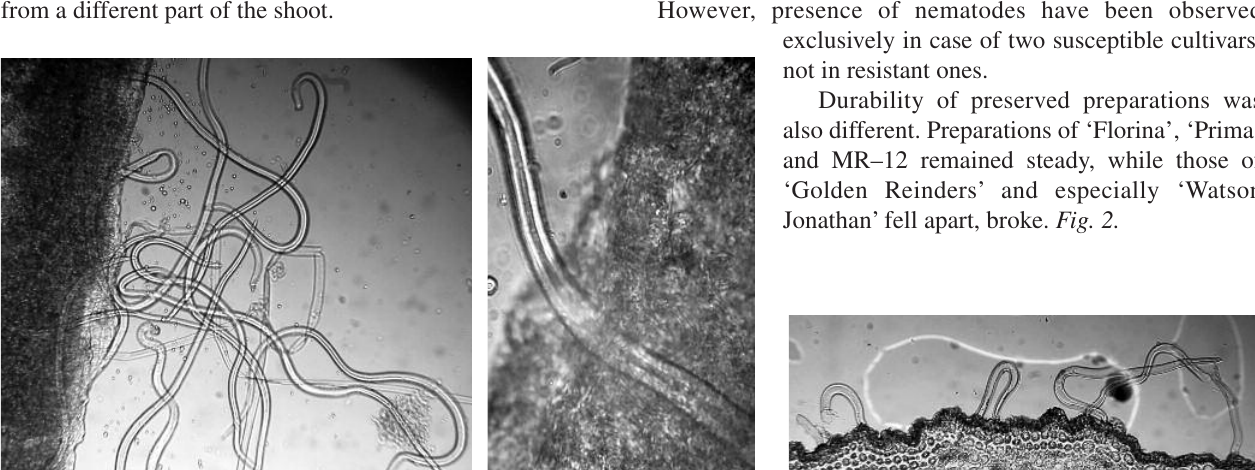
Figure 1. Nematodes appearing around cross sections. Above: nematodes crowding out from leaf, and inside leaf (above right) in cultivar ‘Golden Reinders’. Below: Nematodes appearing along the midrib in cultivar ‘Watson